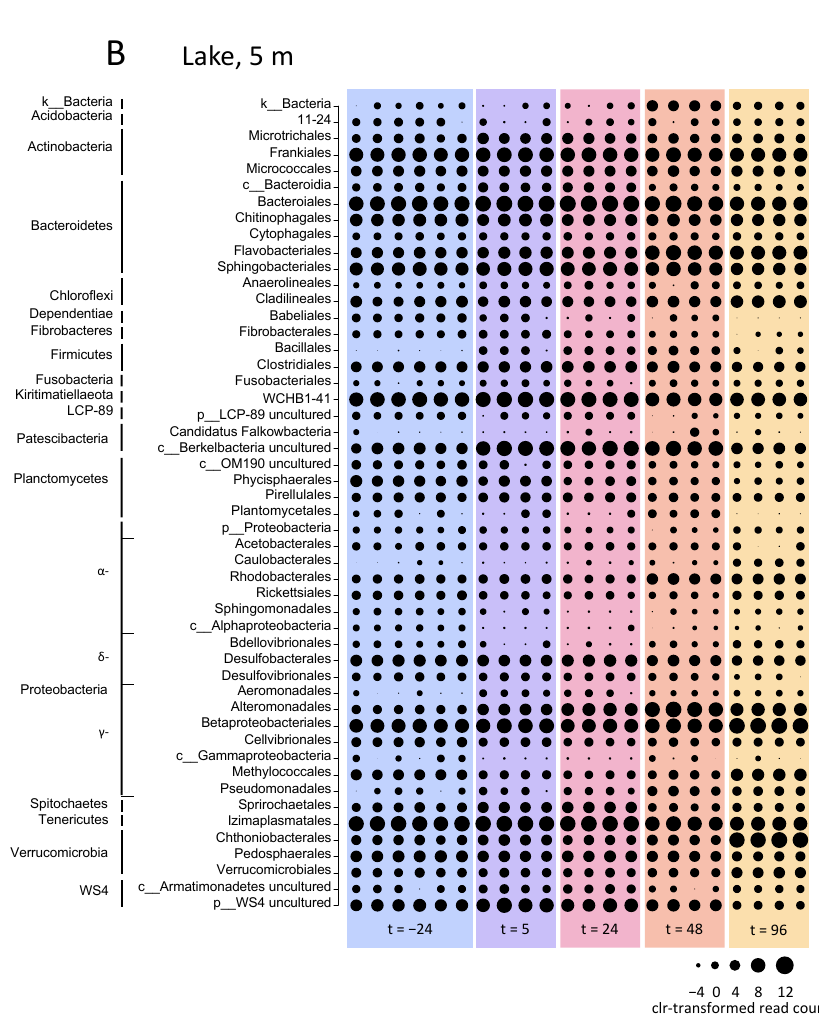
Figure 5. Microbial community composition during the lake treatment in August. Relative abundance shown as clr-transformed read counts at the phylum and order levels at ( A ) the 0-m and ( B ) 5-m depth during the lake treatment in August. Columns of the same color represent biological replicates at the same time point; columns of different colors represent different time points; “k__”, “p__” and “c__” indicate that the maximum classification of these taxa is at the kingdom, phylum and class level,